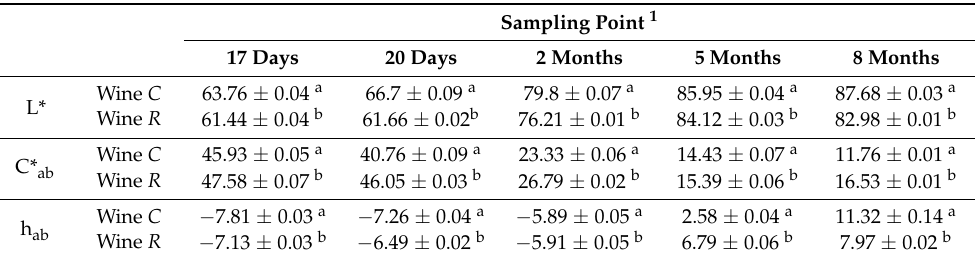
Table 5. Evolution of CIELAB color parameters during winemaking and aging of Wines C (reference wine) and R (added with enological